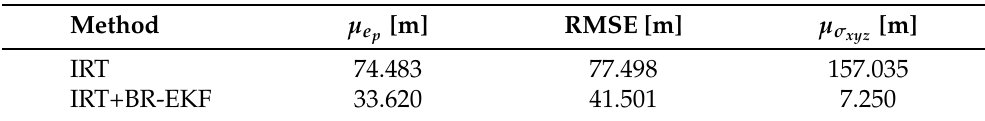
Table 8. Standalone IRT and IRT+BR-EKF filtering results of the mobile phone experimental proce-